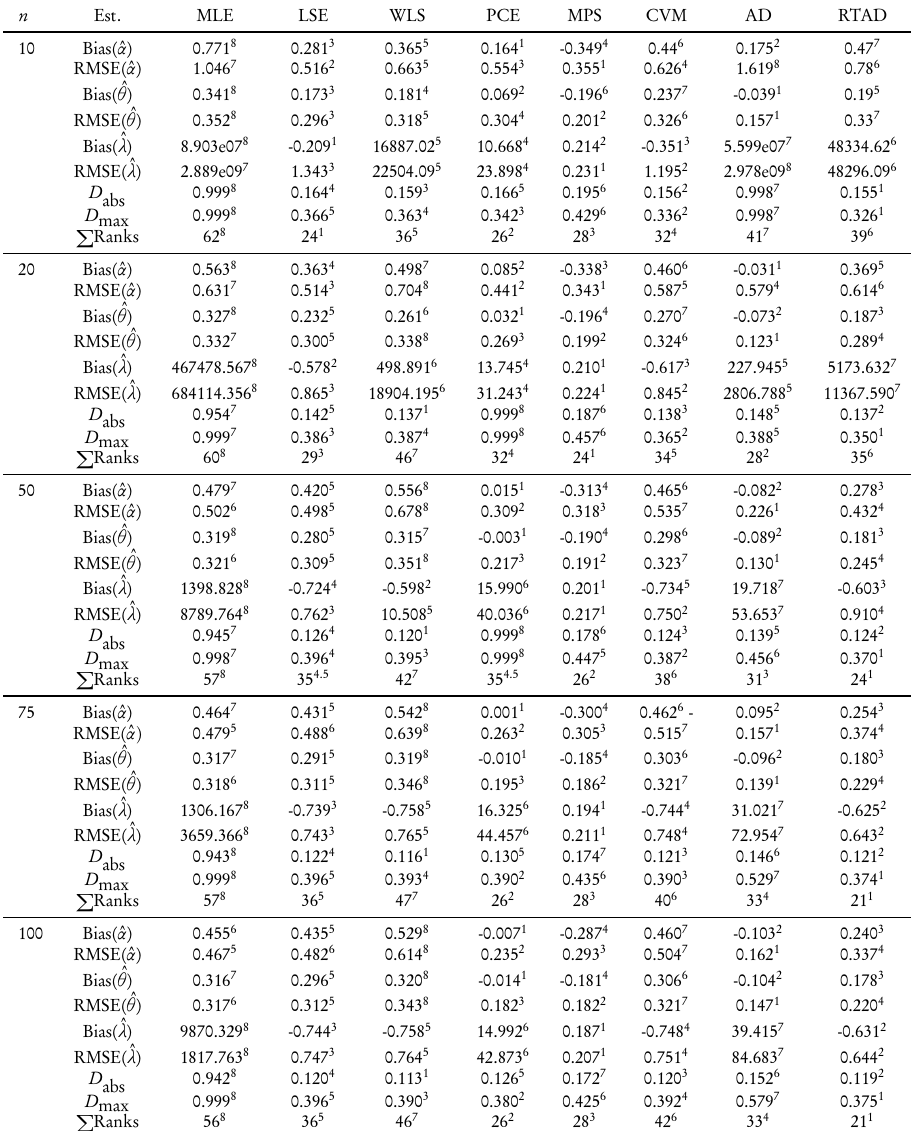
Simulation results for α = 0.5 , θ = 0.7 and λ = 0.7